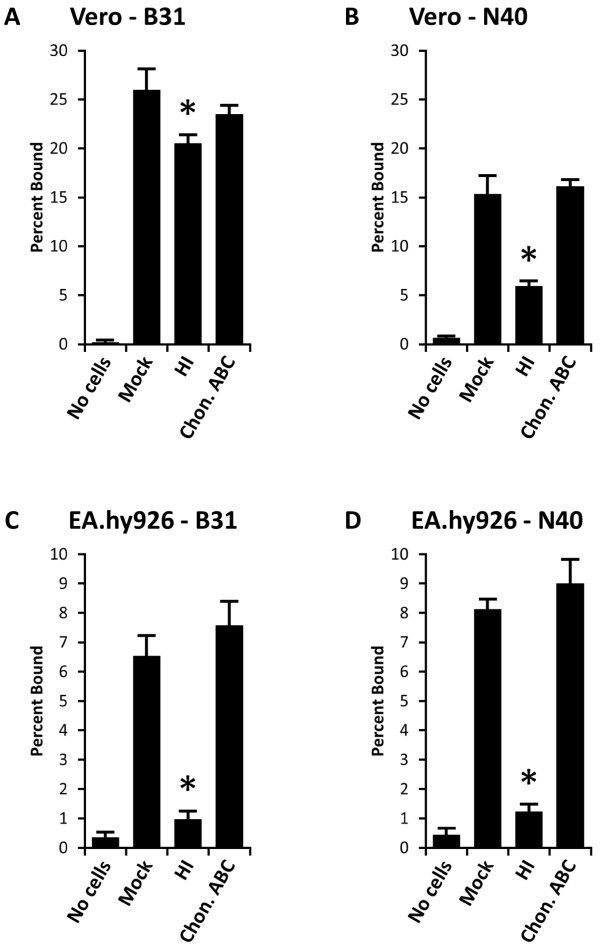
 Binding of B. burgdorferi strains B31 (A and C) and N40D10/E9 (B and D) to both Vero (epithelial) cells and EA.hy926 (endothelial) cells is mediated by heparan sulfate. (A) and (B). Vero cell monolayers were pretreated with the buffer alone (Mock), or with the GAG lyases, heparinase I (HI) to remove heparan sulfate or chondroitinase ABC (Chon. ABC), to cleave chondroitin sulfates from the cell surfaces. Binding of B31 (A) to the Vero cells was significantly higher than that of the N40D10/E9 (B) strain. Although inhibition of binding of both N40D10/E9 and B31 was significant, reduction in binding was more pronounced by N40D10/E9 than B31 when Vero cells were treated with HI (p < 0.05). (C) and (D). EA.hy926 cell monolayers were mock-treated, or pretreated with HI or Chon. ABC enzymes. Removal of heparan sulfate from EA.hy926 cells eliminated the binding of both B31 and N40D10/E9 strains to these cells. The experiments were repeated at least three times using four replicates for each treatment. Each value represents the mean ± SD of quadruplicate samples. Asterisks indicate significant reduction (p < 0.05) in binding percentage compared to mock-treated cells as determined by t-test for pairwise comparison of samples with unequal variance.